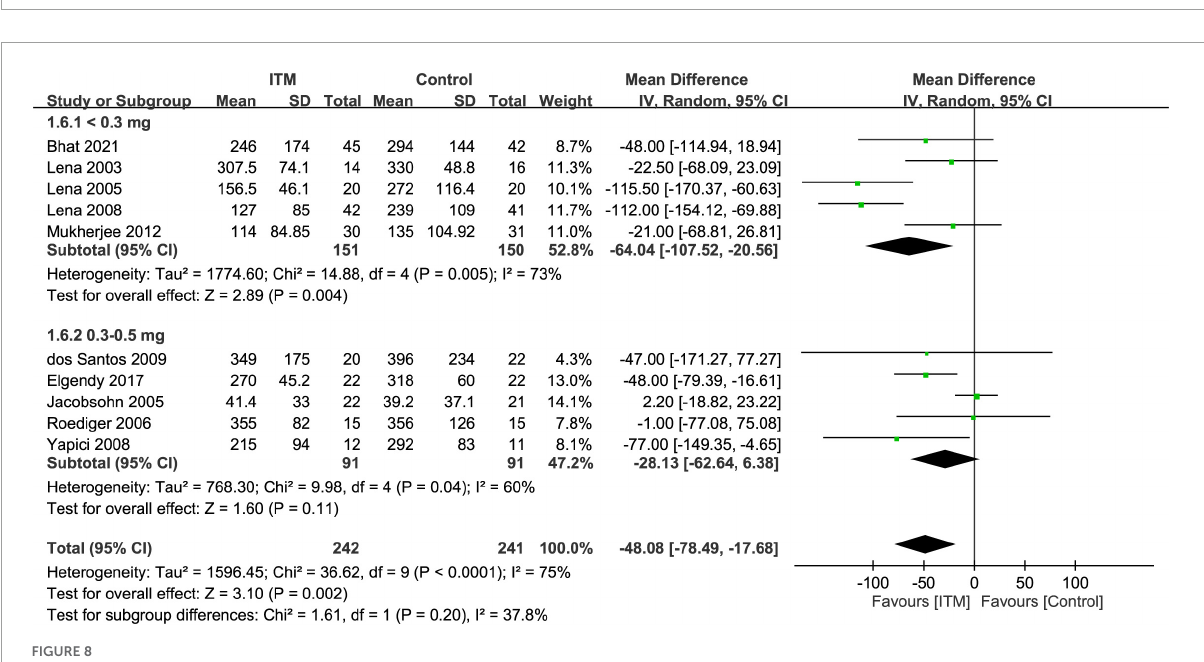
FIGURE8 Forest plot comparing extubation time between intrathecal morphine (ITM) and control groups. CI, confidence interval; IV, inverse variance; SD, standard